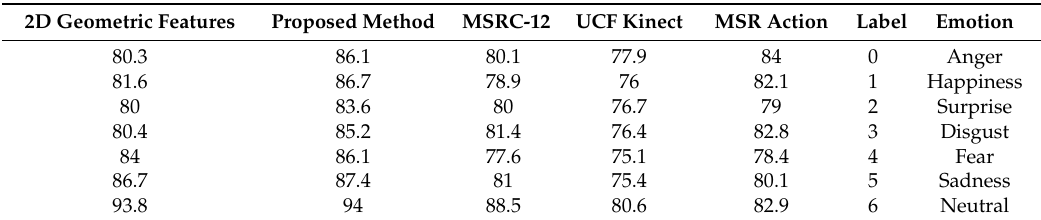
Table 9. F-Score comparison for multimodal emotion